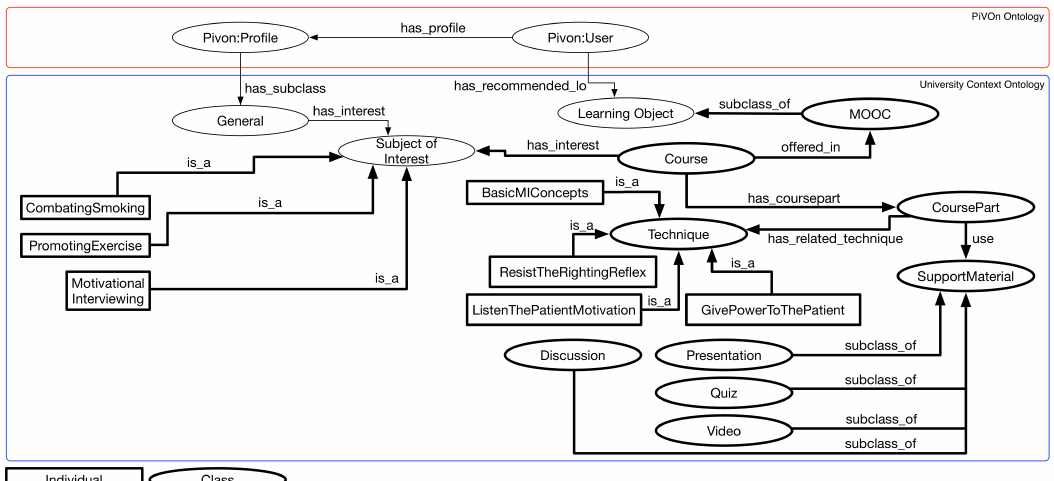
Figure 12. Semantic Network generated in the Context Workflow.